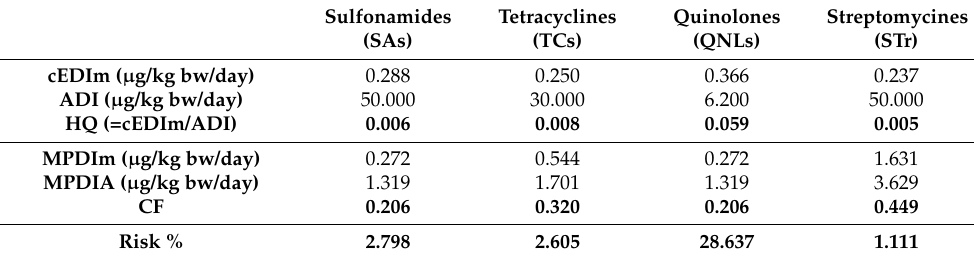
Table 7. Hazard characterization parameters (by ELISA analysis).